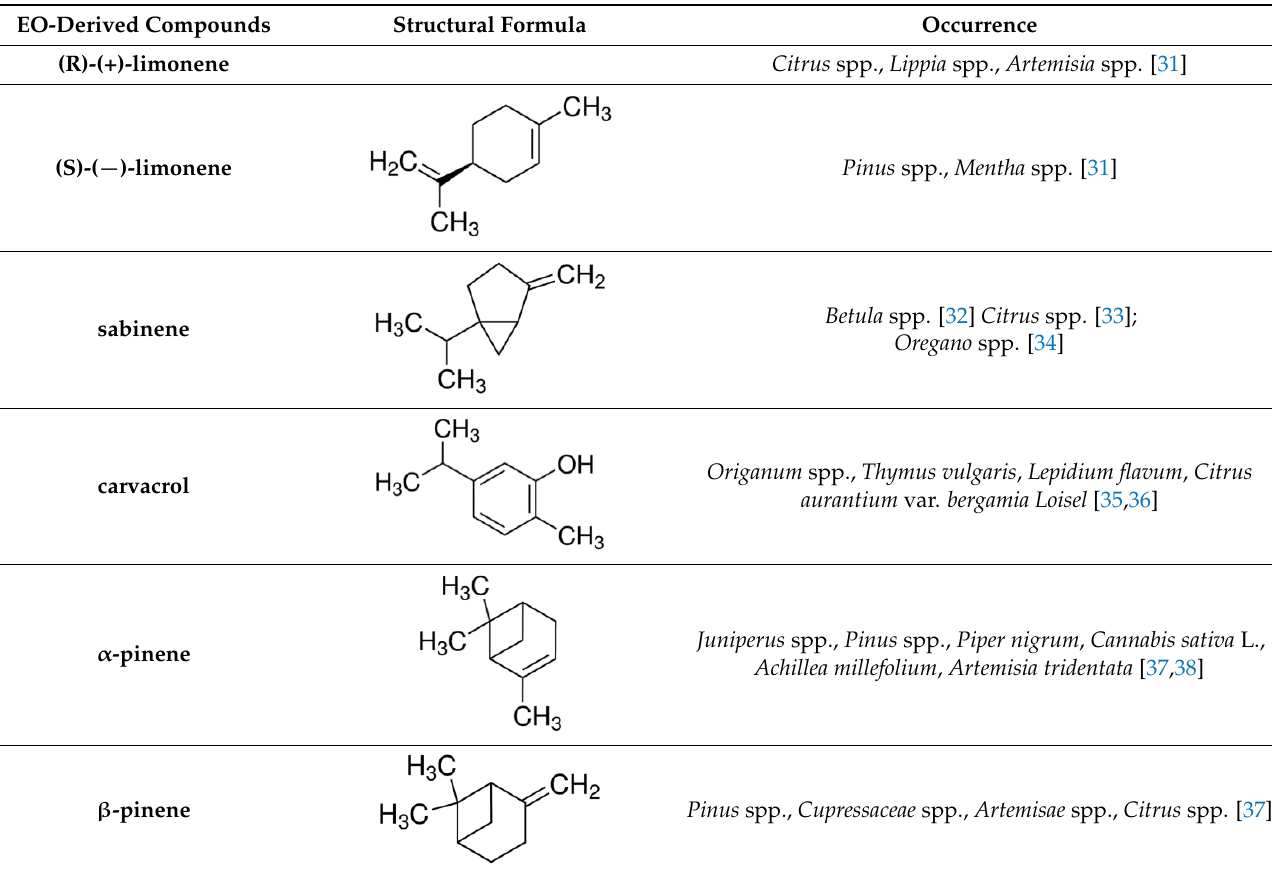
Table 1. Occurrence and structural formulas of the tested EO-derived compounds.